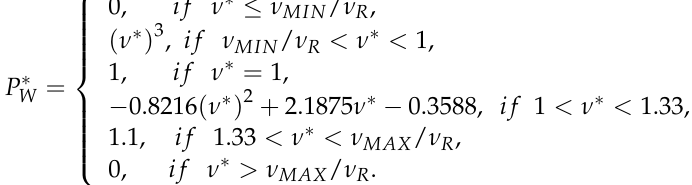
Figure 2. Load schedule of LO ( P LC ( t )—load power, P C -load added power, P LIM —limit of the power, P g —grid power, ρ —coefficient of power increasing, P L (t) —basic load schedule).